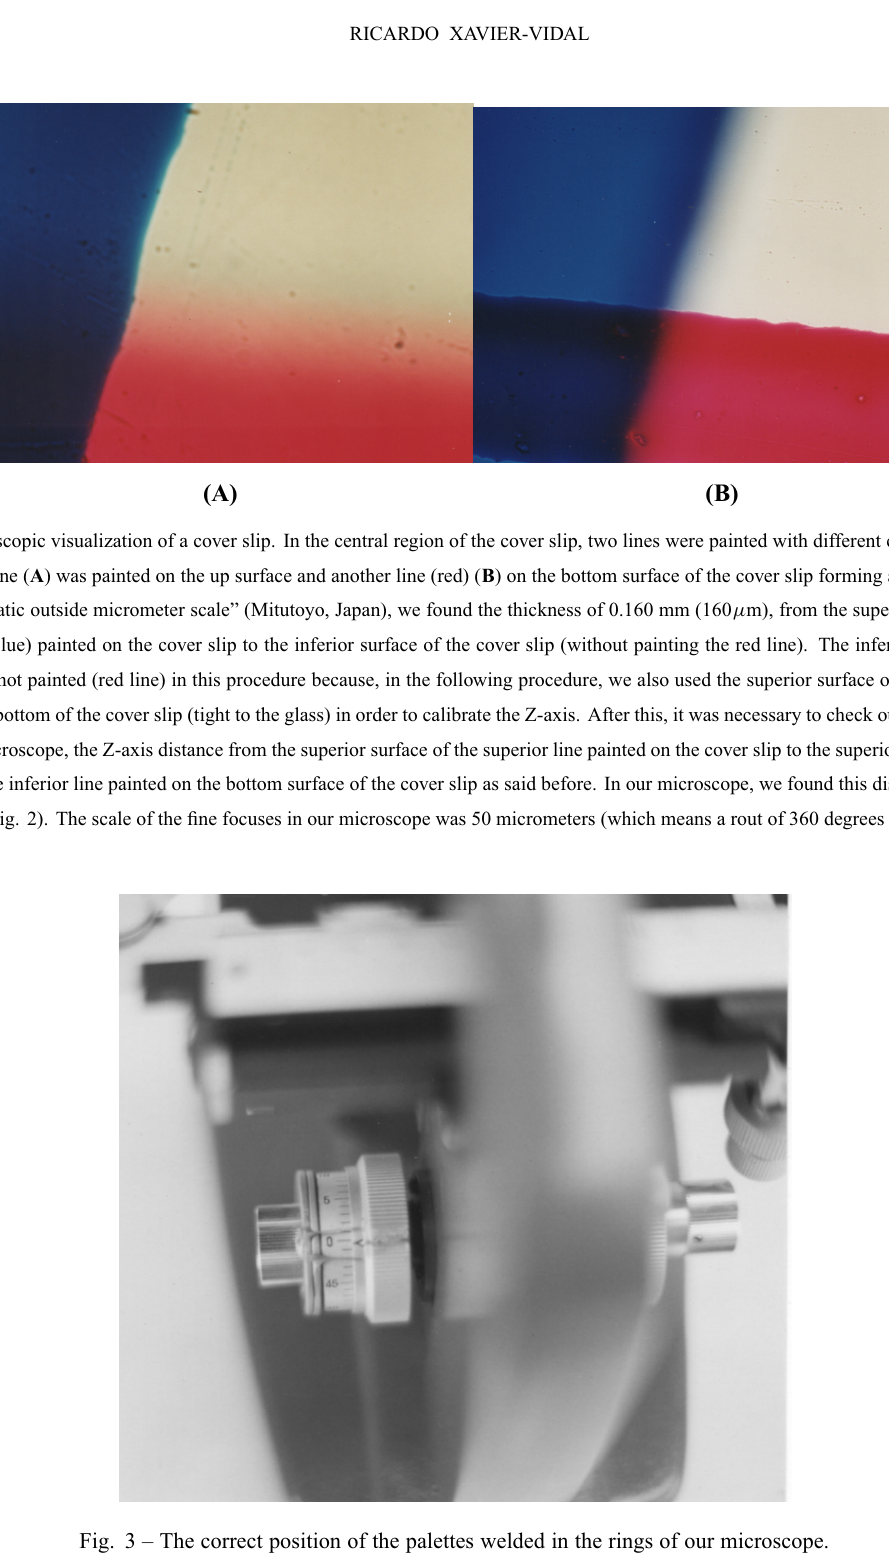
Fig. 3 – The correct position of the palettes welded in the rings of our microscope. The distance from one palette to the other was estimated as 3.2 marks ( μ m) of the fine focuses, means 10 μ m in Z-axis of the microscope (Optical Disector of 10 μ